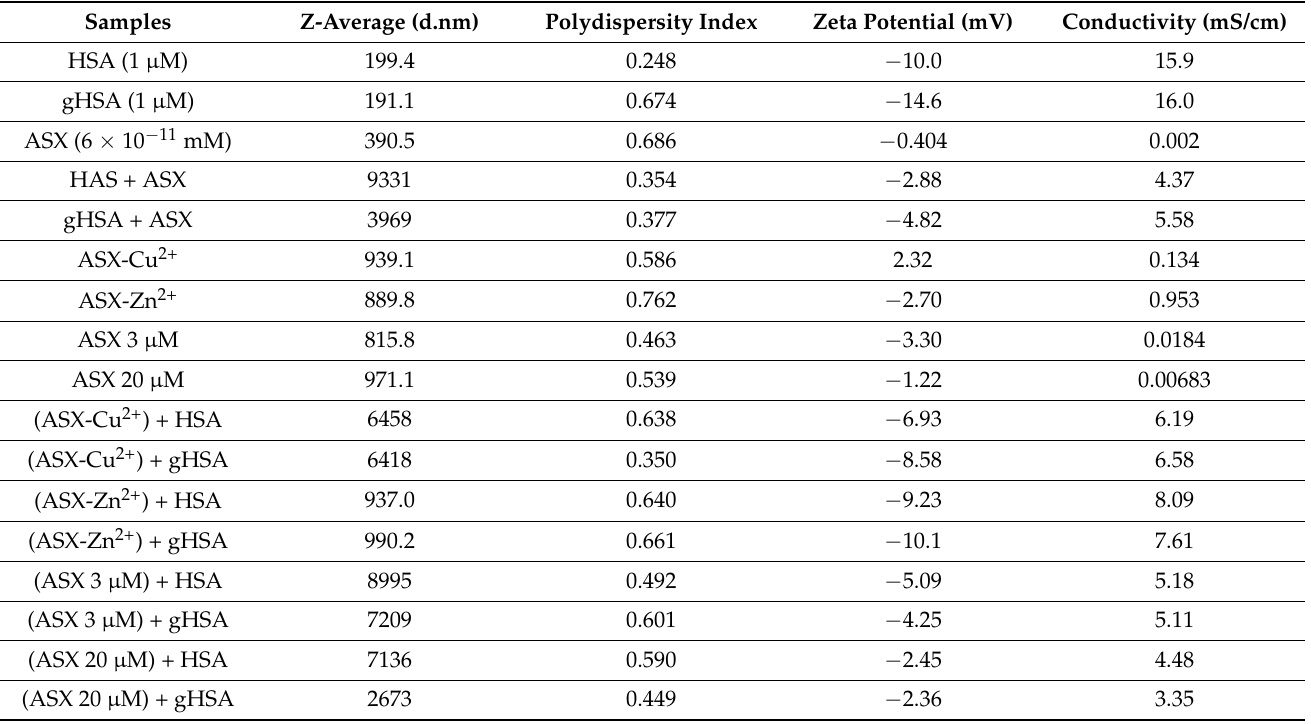
Table 1. Particle size, zeta potential and conductivity data for ASX and ASX-metal ions + HSA/gHSA